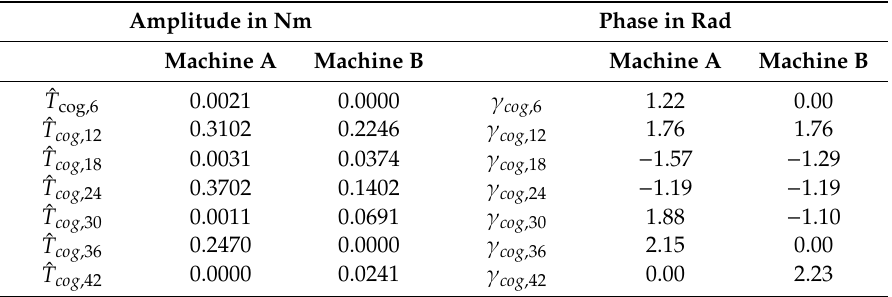
Table 5. Amplitudes and phases of the Fourier transformed cogging